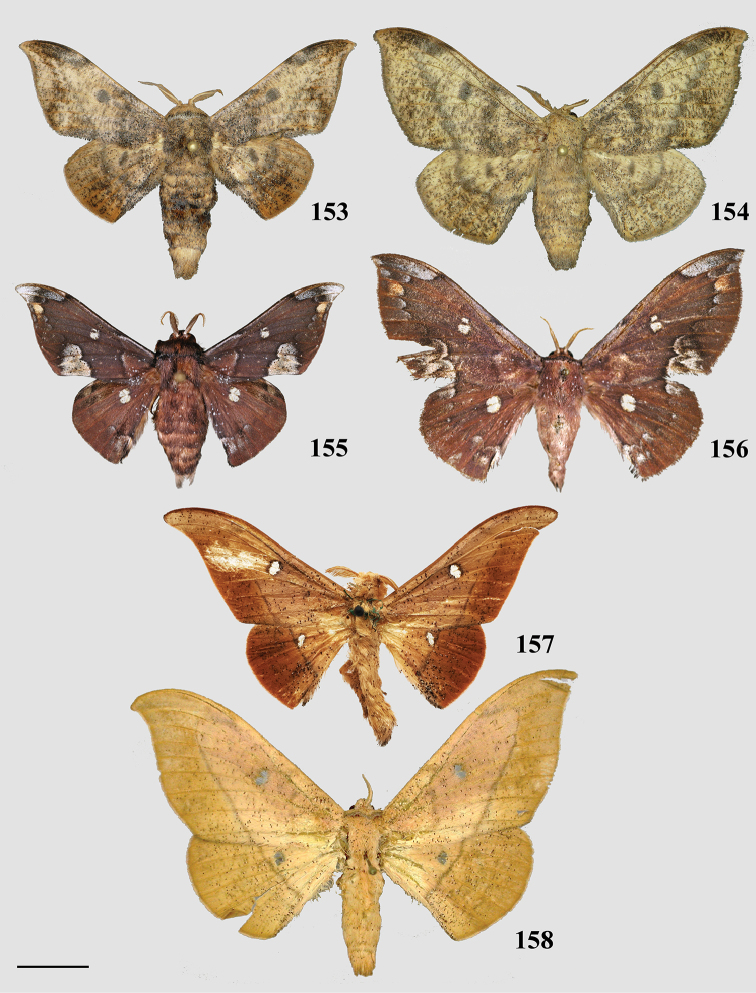
Adult specimens of type species of genera belonging to Cicinninae: Cicinnini. 153Cicinnuscforthane, male [reused with permission St Laurent et al. (2018c), Zootaxa] (CGCM) 154C.cforthane, female [reused with permission St Laurent et al. (2018c), Zootaxa] (CGCM) 155Roelmanamaloba, male [photo R Lahousse] (MNHN) 156R.maloba, female [photo R Lahousse] (MNHN) 157Isoscellaventana, male [photo T Malm] (NHRS) 158I.ventana, female [photo S Naumann] (ZSM). Scale bar: 1 cm.